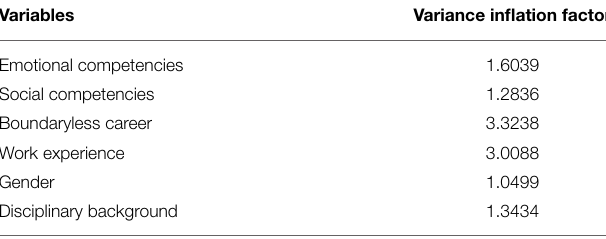
TABLE 5 | Variance inflation factor.